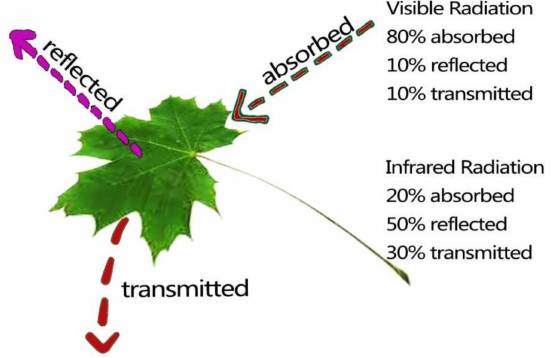
Figure 15. The absorption, transmission, and reflection of radiation in a single leaf layer (adapted from Ref.